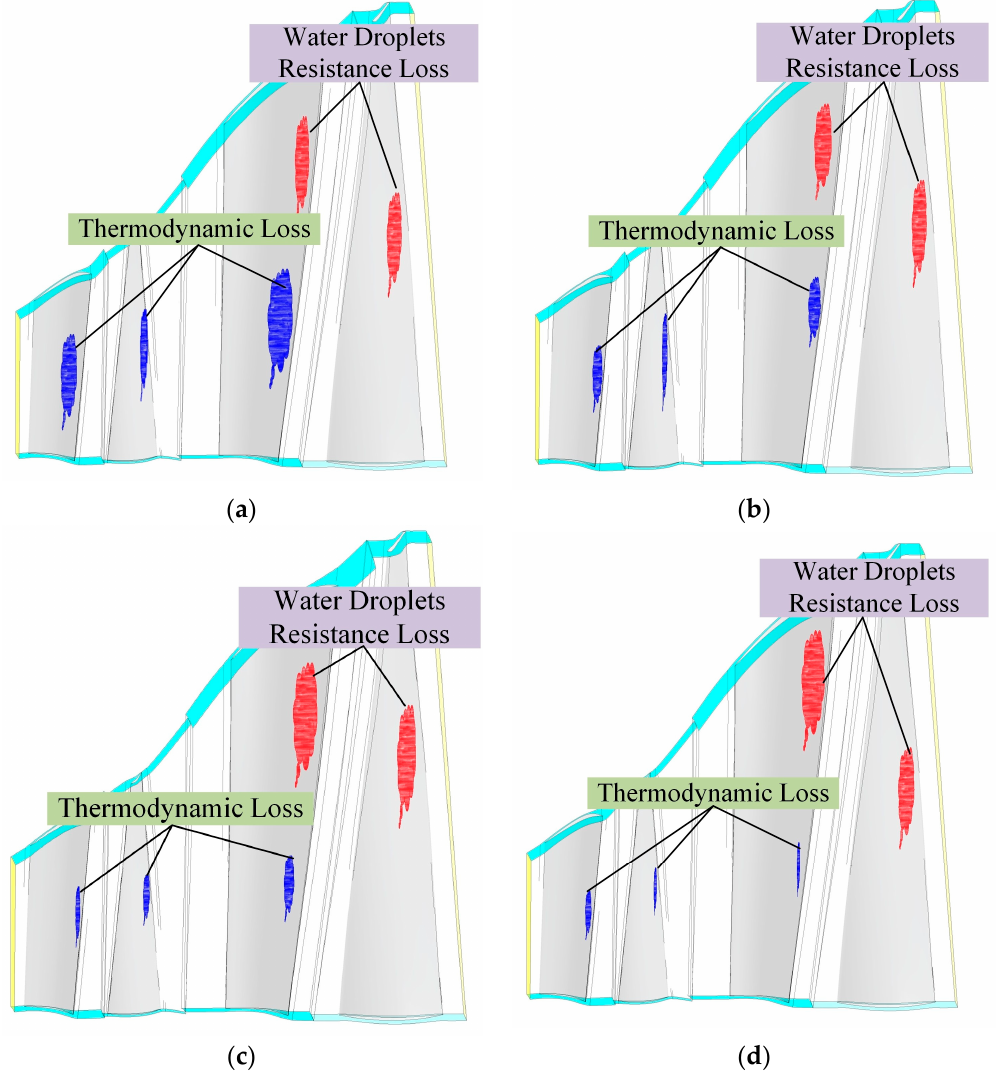
Figure 8. Distribution of high wetness loss area under different working conditions. ( a – d ), respec- tively, represent 100%, 50%, 40%, and 30% THA.